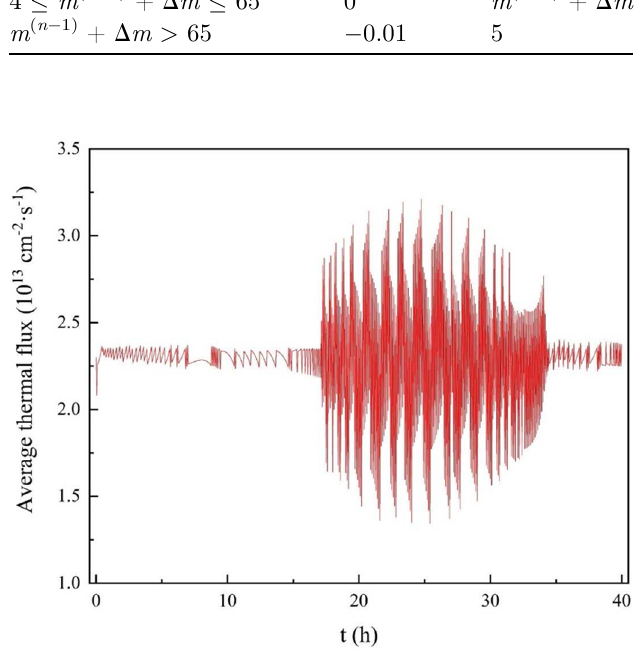
Fig. 11. Evolution of the average thermal fl ux (unsymmetric control).